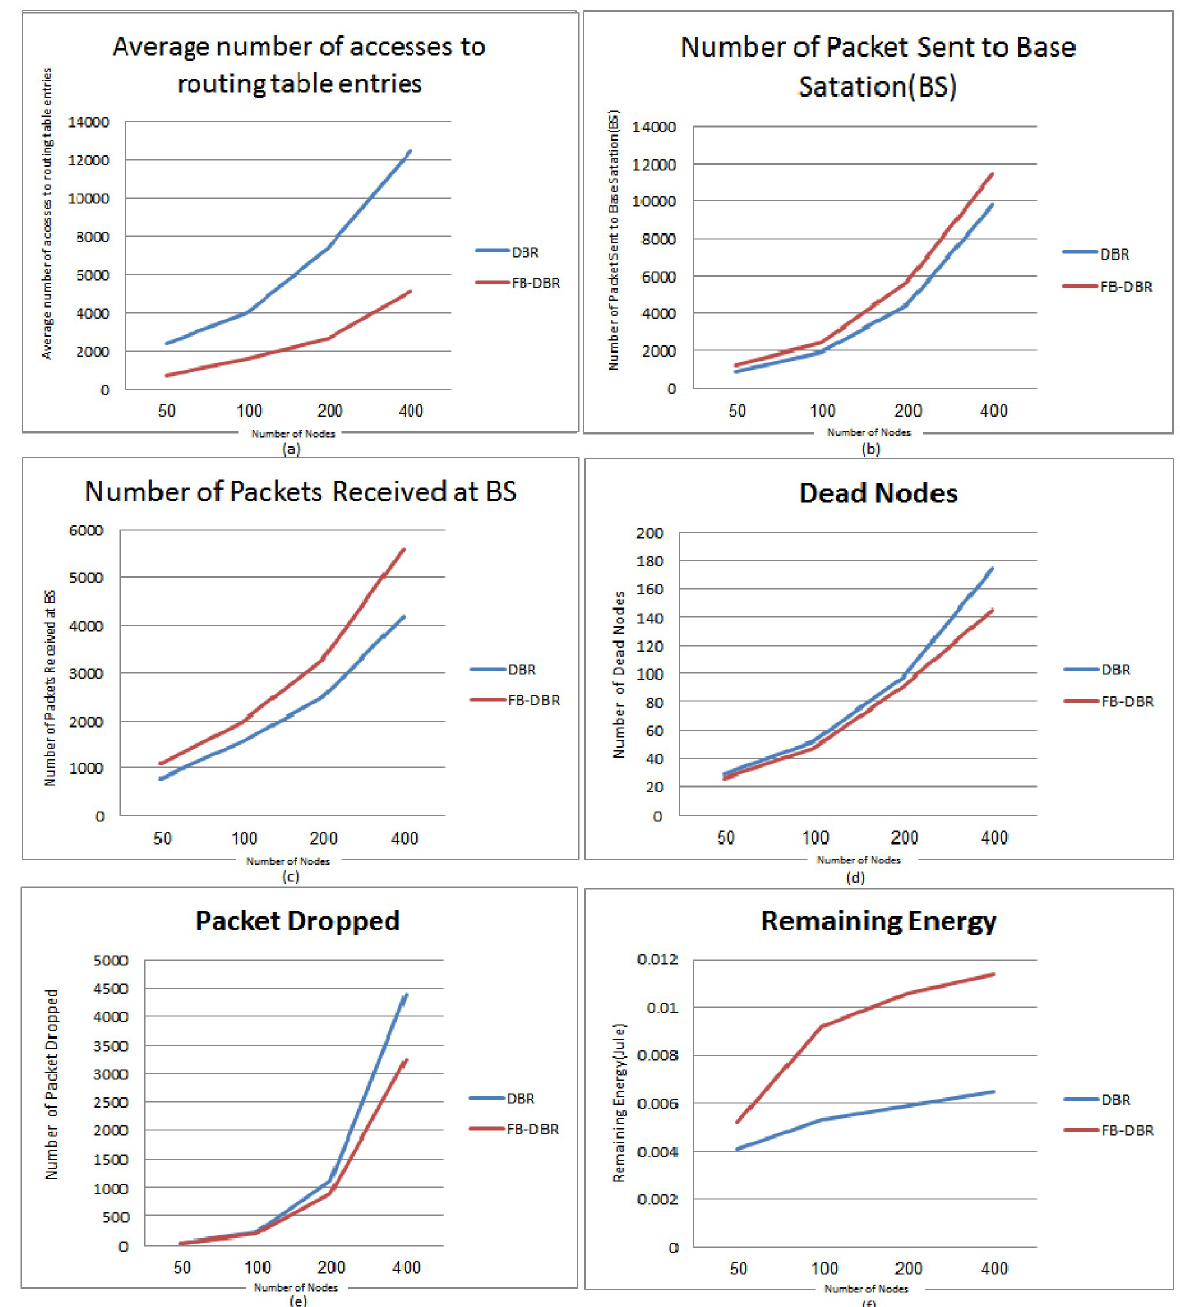
Fig 9. FB-DBR and DBR outputs based on the Number of